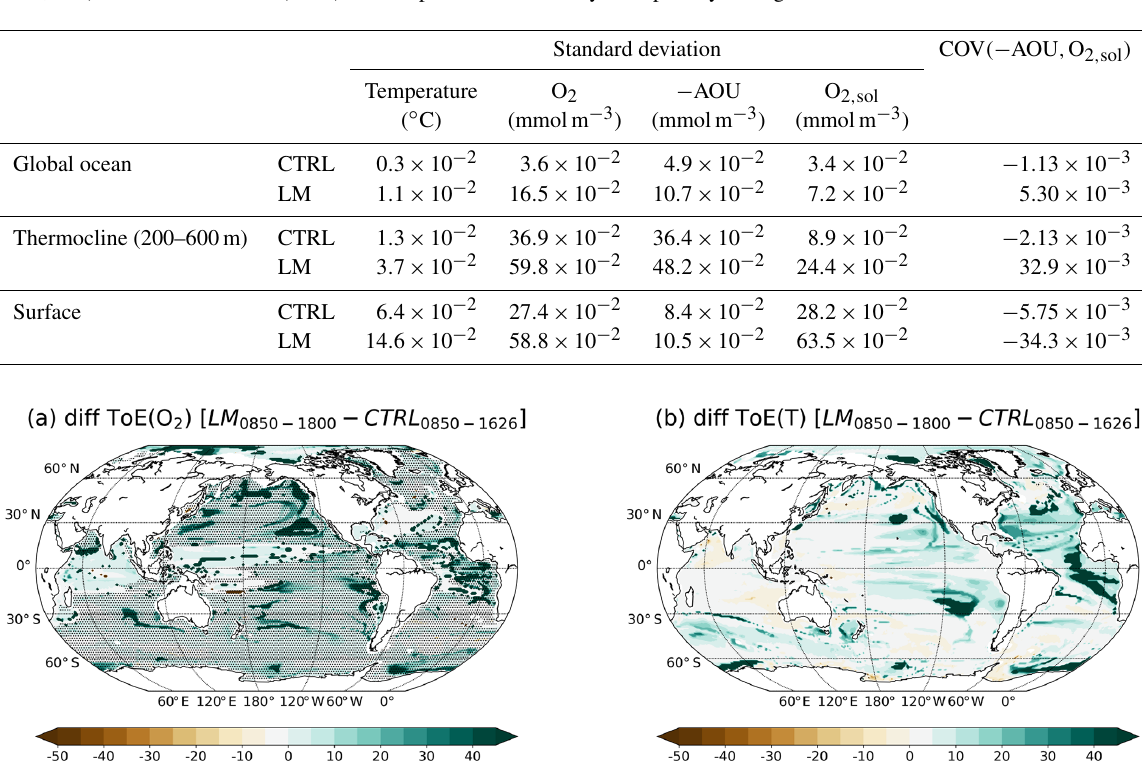
Figure 5. Difference of ToE for (a) O 2 and (b) T using the SD of the forced simulation (850–1800CE) minus the ToE using the SD of the control simulation. The dashed areas in panel (a) indicate where O 2 decreases under